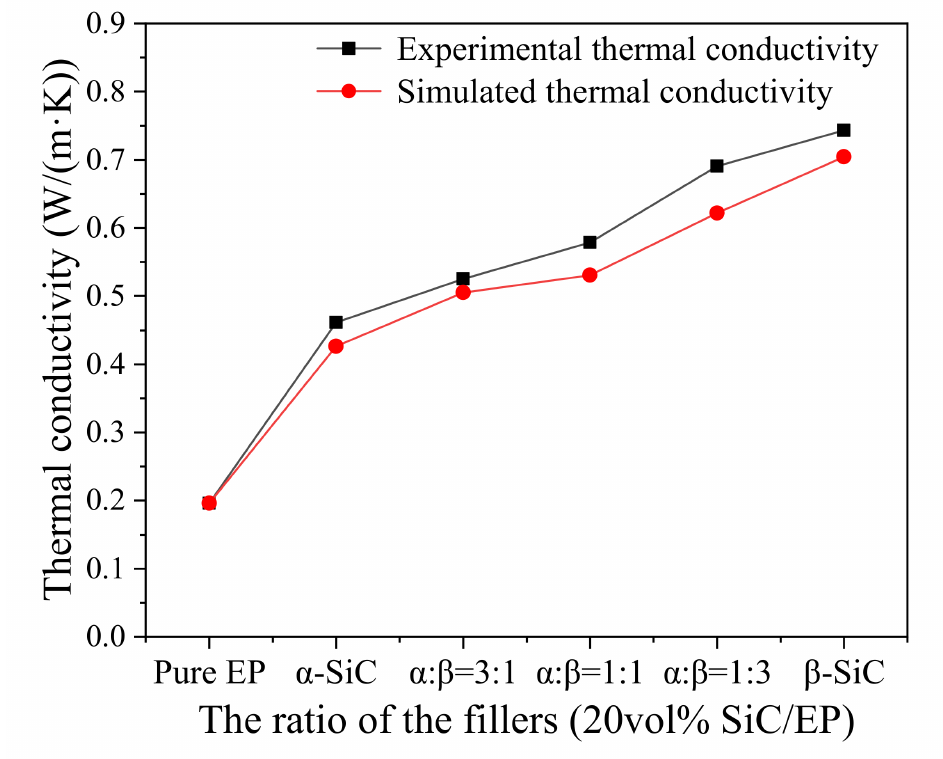
Figure 15. Comparison of experimental and simulated composite thermal conductivity